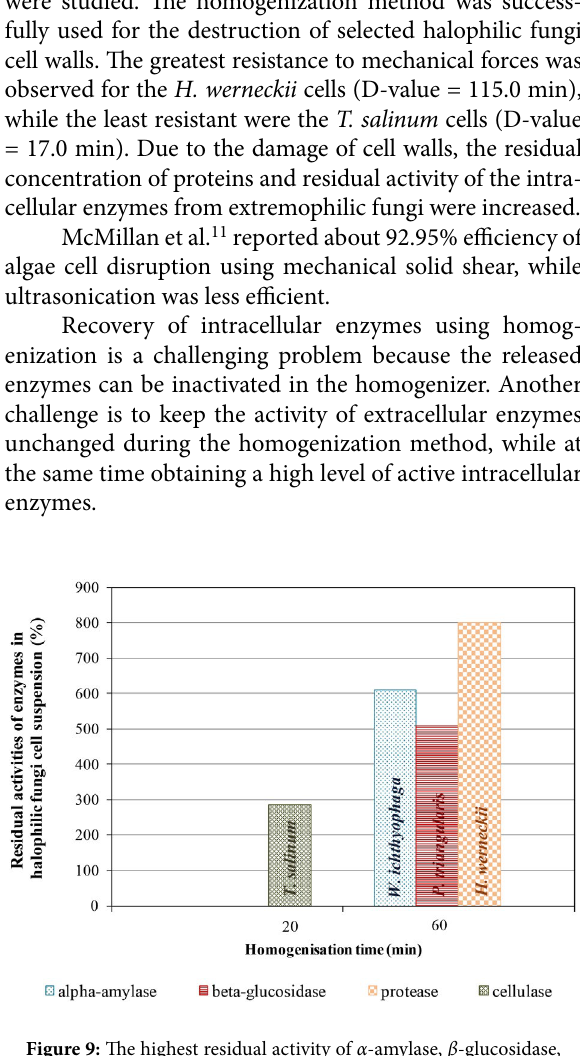
Figure 9: The highest residual activity of α -amylase, β -glucosidase, cellulase and protease obtained in various halophilic fungi cell sus- pensions vs. optimal homogenization